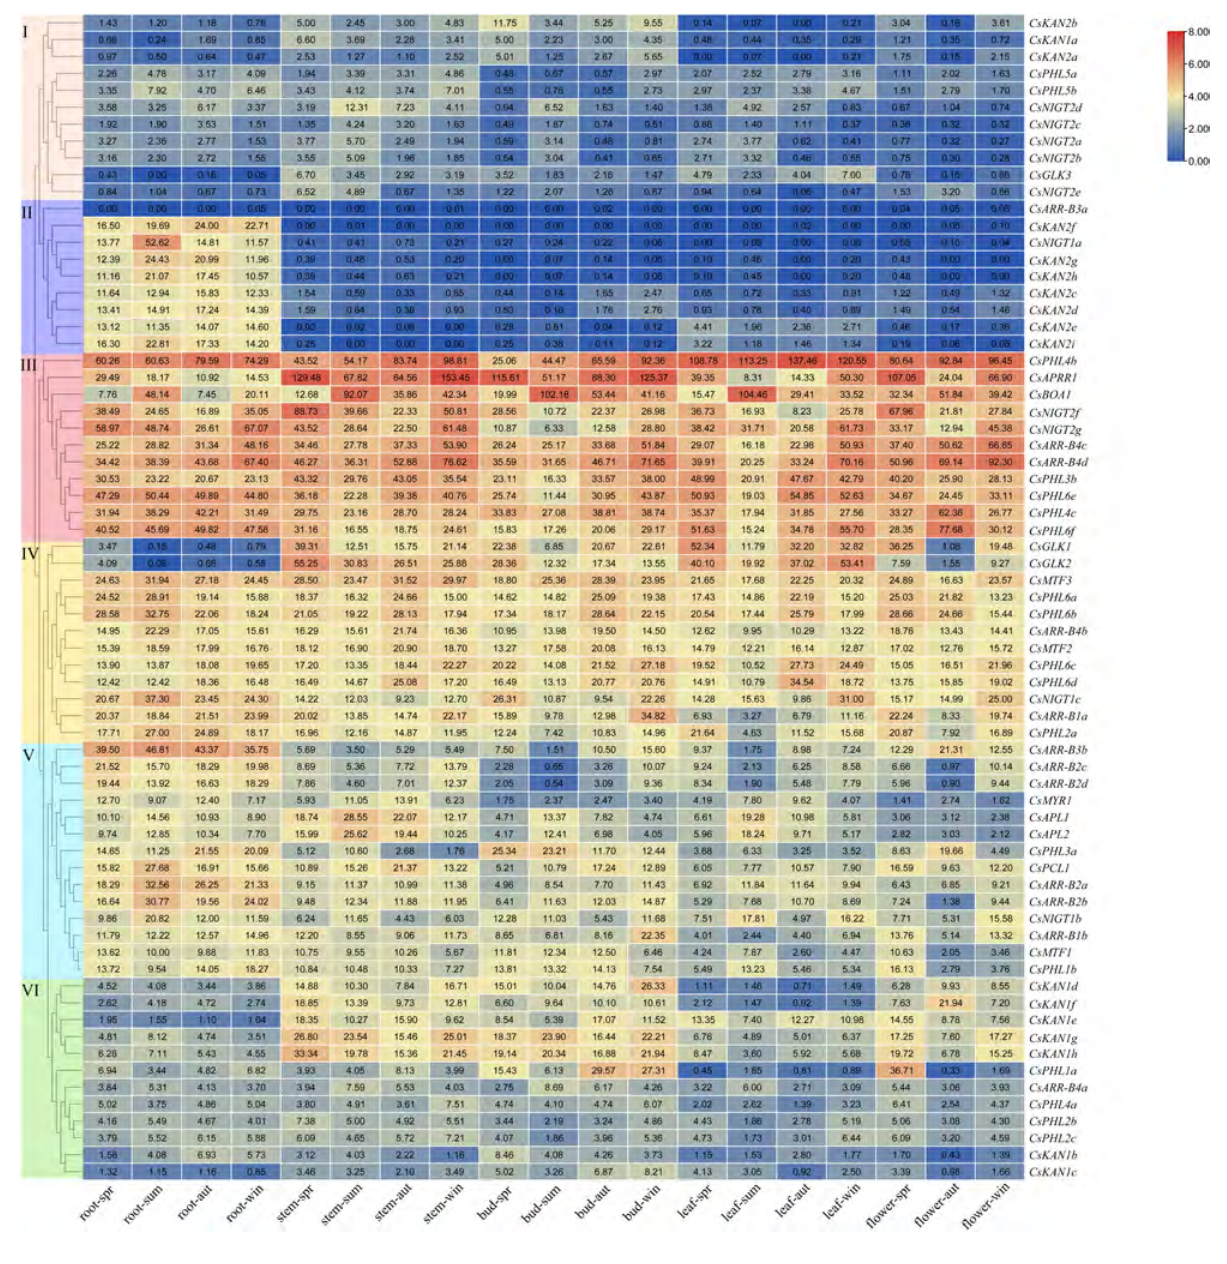
FIGURE 8 | Expression analysis of CsGARPs in different tissues in different seasons. The CsGARPs were clustered into 6 groups with different colors according to their expression levels calculated with TPM values. The red and blue colors represent high and low expression levels,